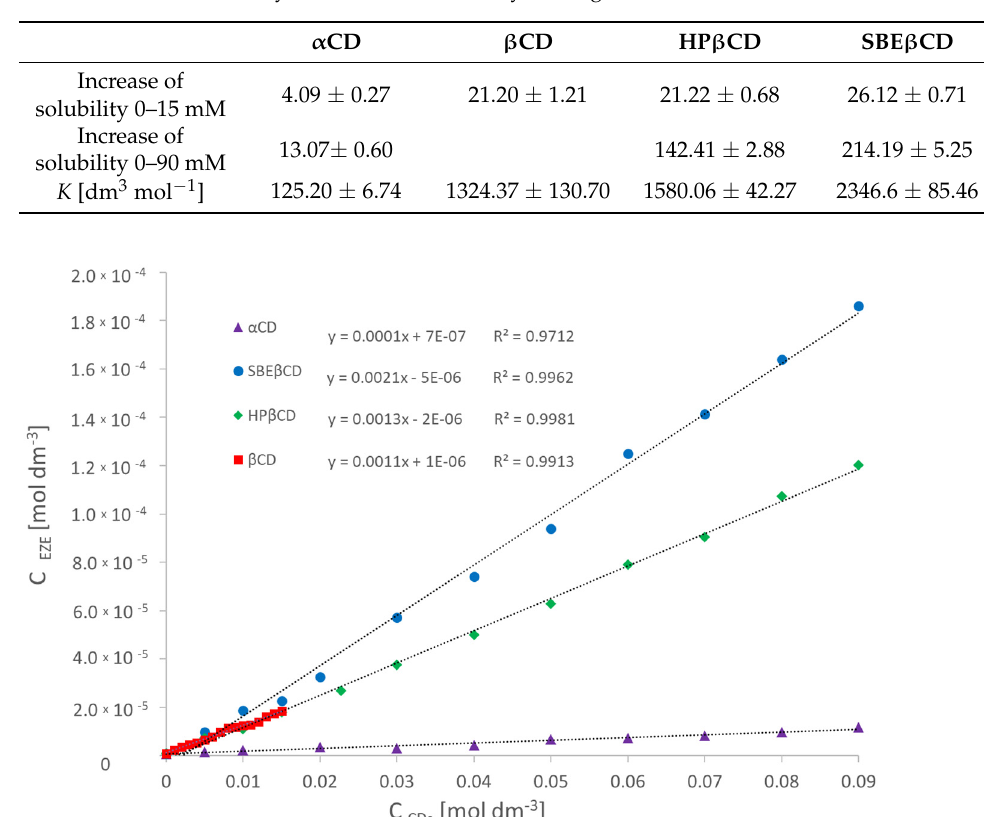
Table 2. Experimentally determined increase in ezetimibe solubility for selected cyclodextrins up to 15 and 90 mM and stability constants calculated by the Higuchi–Connors method.